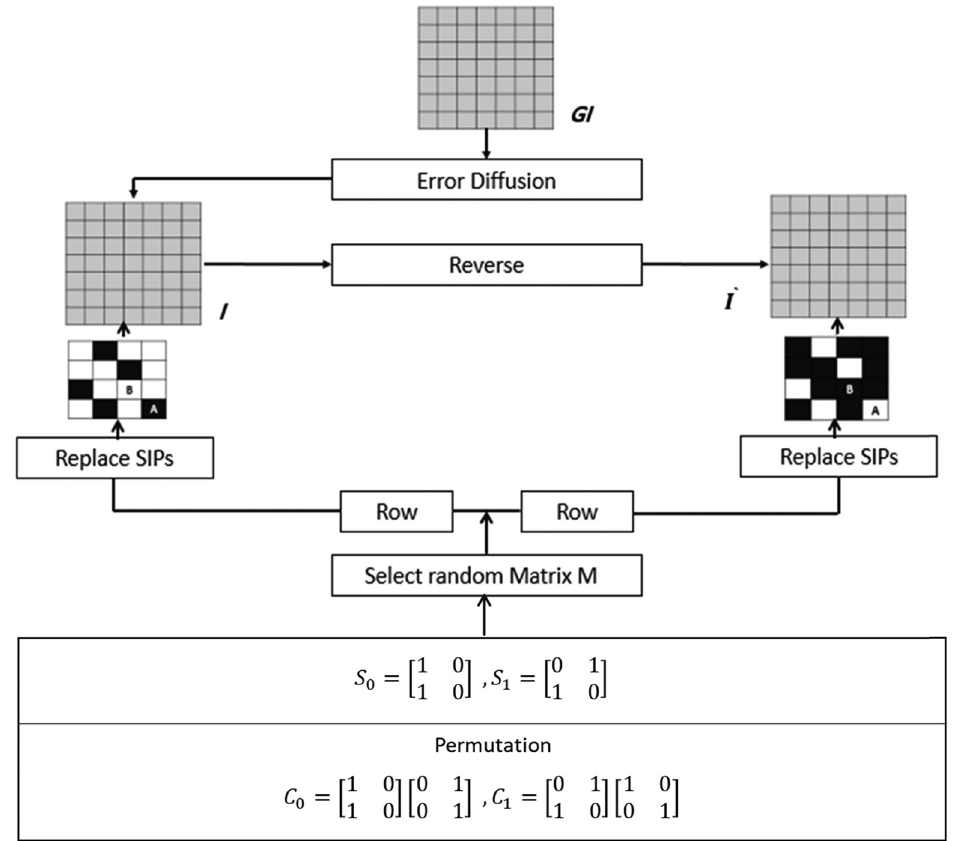
Figure 2: Block diagram for ( 2 - out - of - 2 ) HVC scheme with halftone cell size q = 4 [ 4 ]